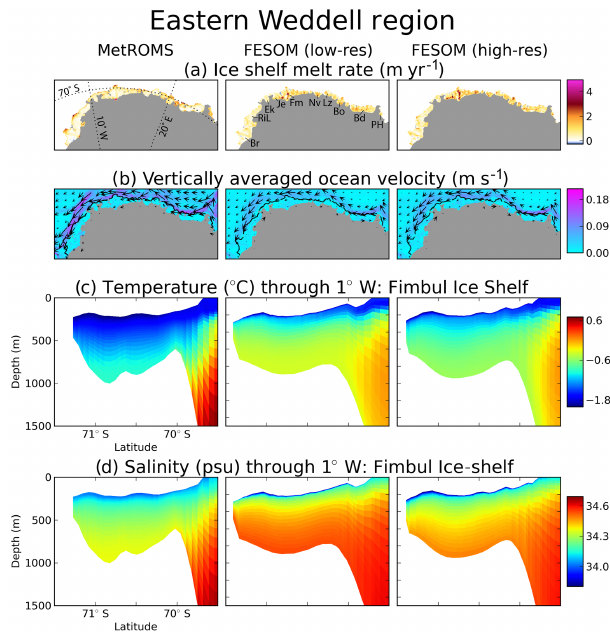
Figure 12. (a, b) As Fig. 11a and b for the eastern Weddell ice-shelf cavities. (c) Temperature ( ◦ C) and (d) salinity (psu) interpolated to 1 ◦ W, through the Fimbul Ice Shelf. Br indicates Brunt Ice Shelf, RiL indicates Riiser–Larsen Ice Shelf, Ek indicates Ekström Ice Shelf, Je indicates Jelbart Ice Shelf, Fm indicates Fimbul Ice Shelf, Nv indicates Nivl Ice Shelf, Lz indicates Lazarev Ice Shelf, Bo indi- cates Borchgrevink Ice Shelf, Bd indicates Baudouin Ice Shelf, and PH indicates Prince Harald Ice